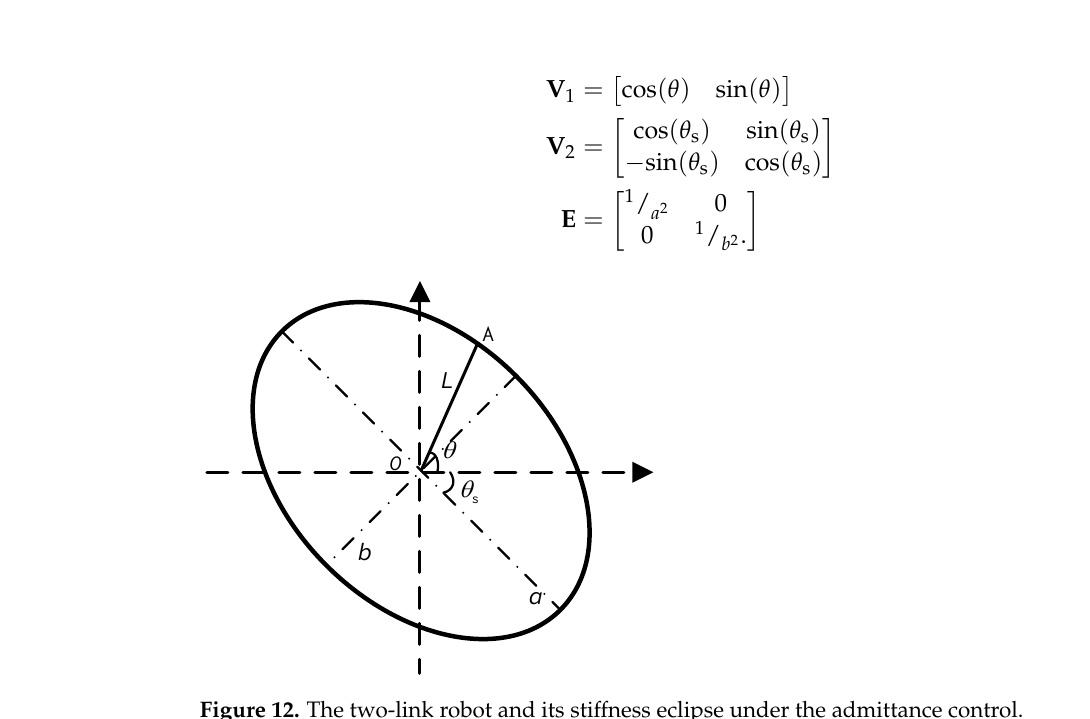
Figure 12. The two-link robot and its stiffness eclipse under the admittance control. The desired trajectory contains an acceleration process and a deceleration process to ensure that the velocity and acceleration at the beginning and the end are both zero. Since the door’s geometric and dynamic information are agnostic to the robot, different circular input trajectories will result in different actual motions. When the input trajectory is a quarter-circle arc with a radius of 0.45 m and 0.35 m respectively, the motion trajectories of the end-effector are shown in Figure 13.